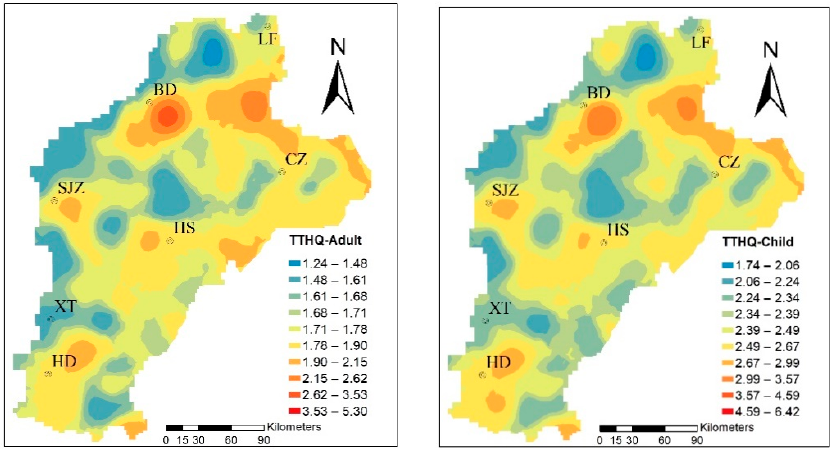
Figure 7. The distribution map of TTHQ for adults and children in the study area.